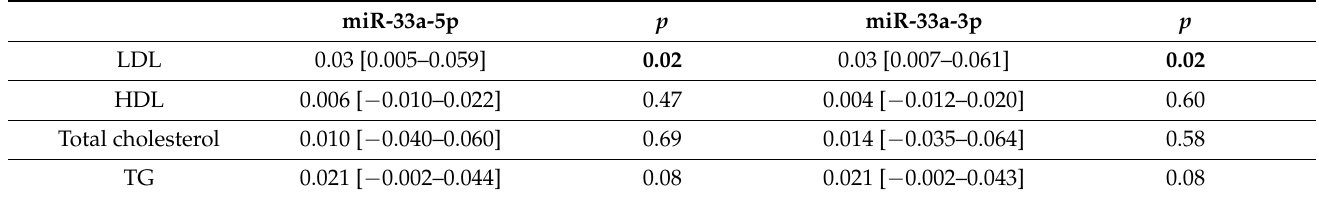
Table 4. Univariable linear regression analysis (miR-33a-5p/3p levels—independent variables).